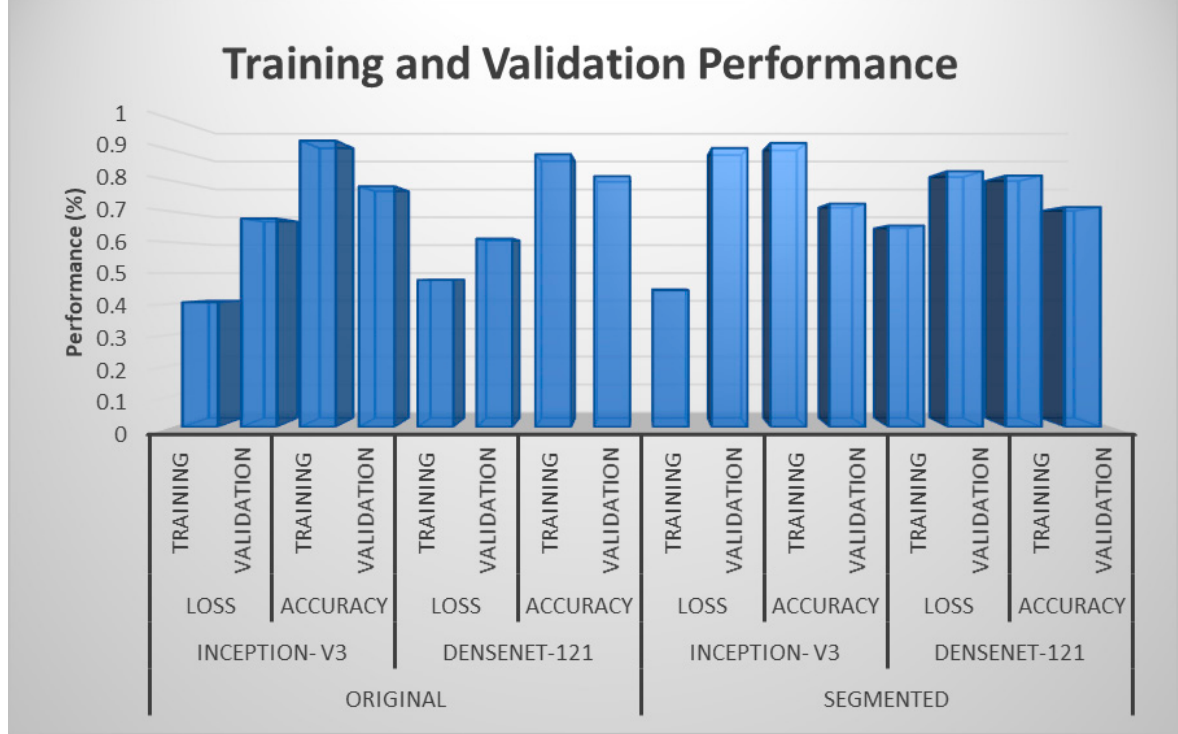
Figure 3. Training and validation performances for two different models.